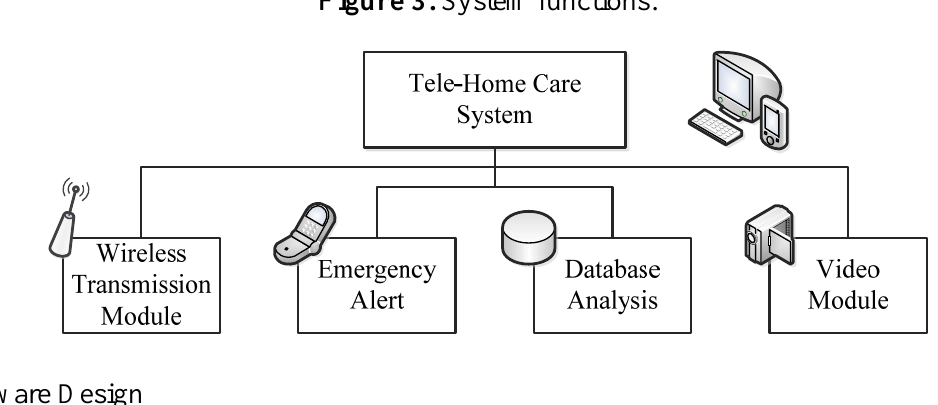
Figure 3. System